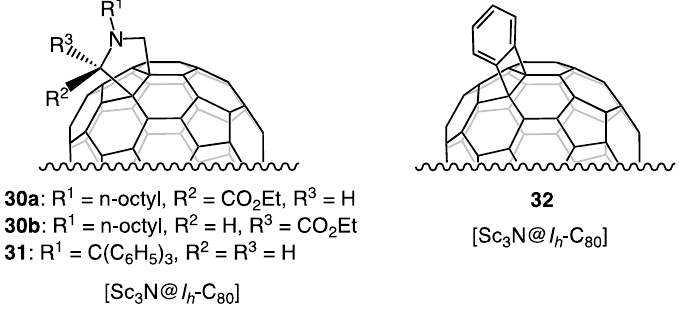
Figure 7. Partial structures of 30a , 30b , 31 and 32 .